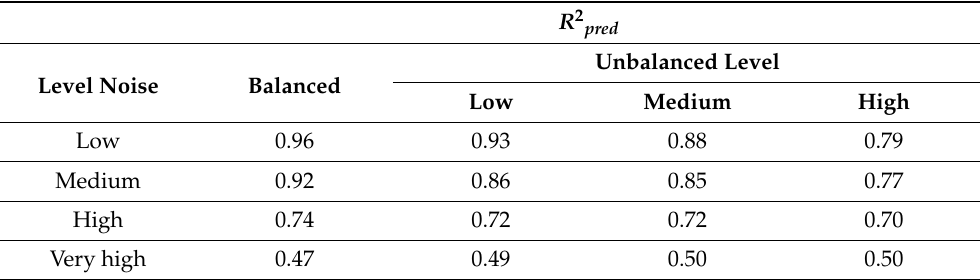
Table 17. Behavior of the R 2 pred statistic at different noise and unbalanced levels.